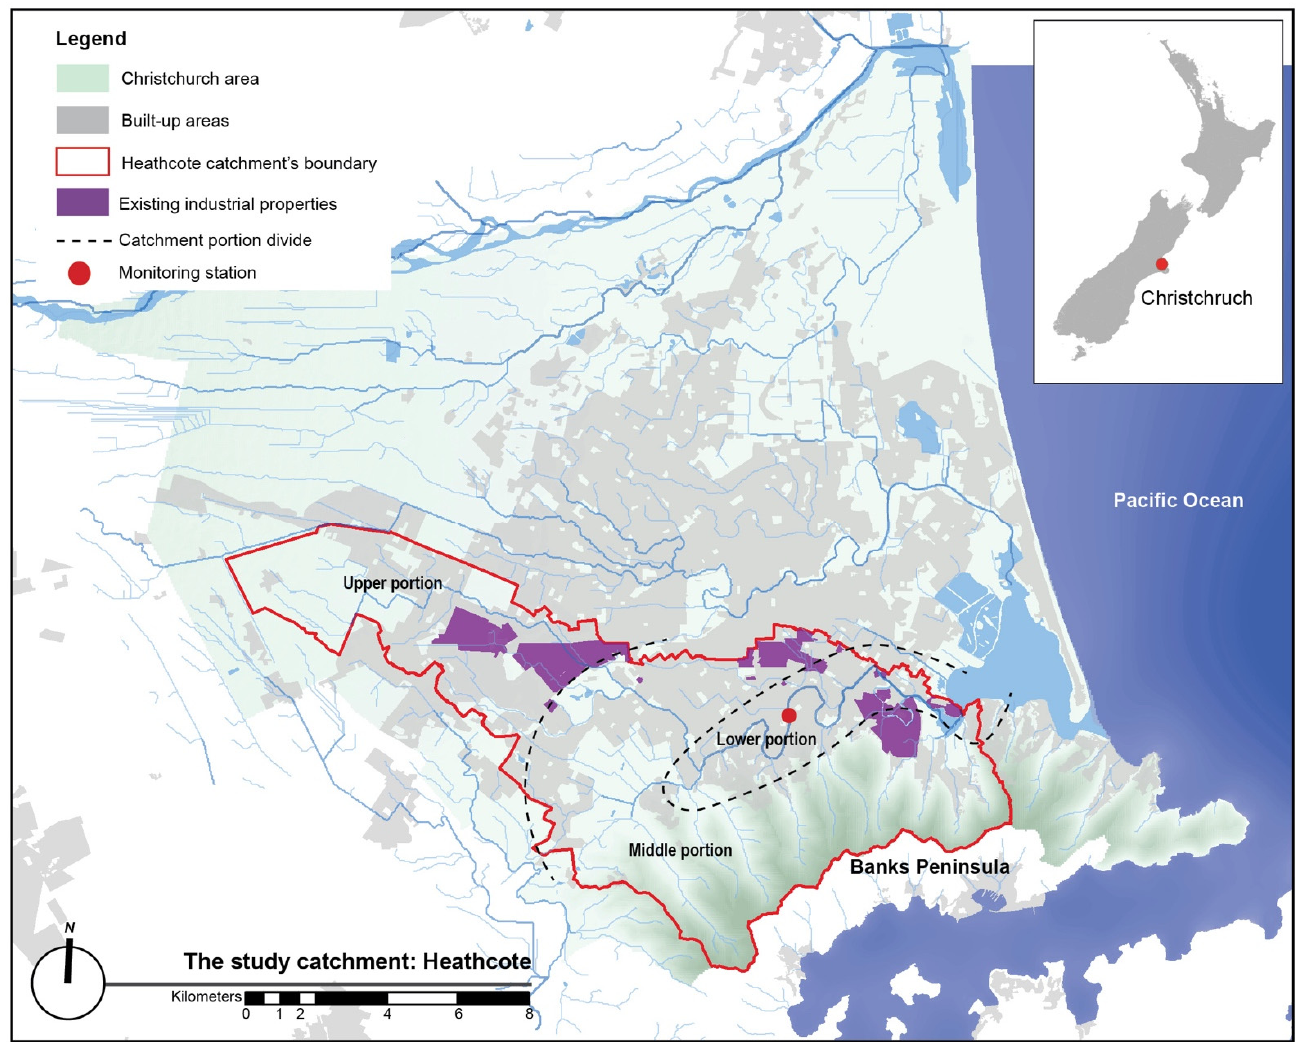
Figure 1. Industrial properties are located across the Heathcote catchment in the south of Christchurch, New Zealand. The catchment is a short, wide basin which can be divided into upper, middle, and lower portions, according to Ries III [22].